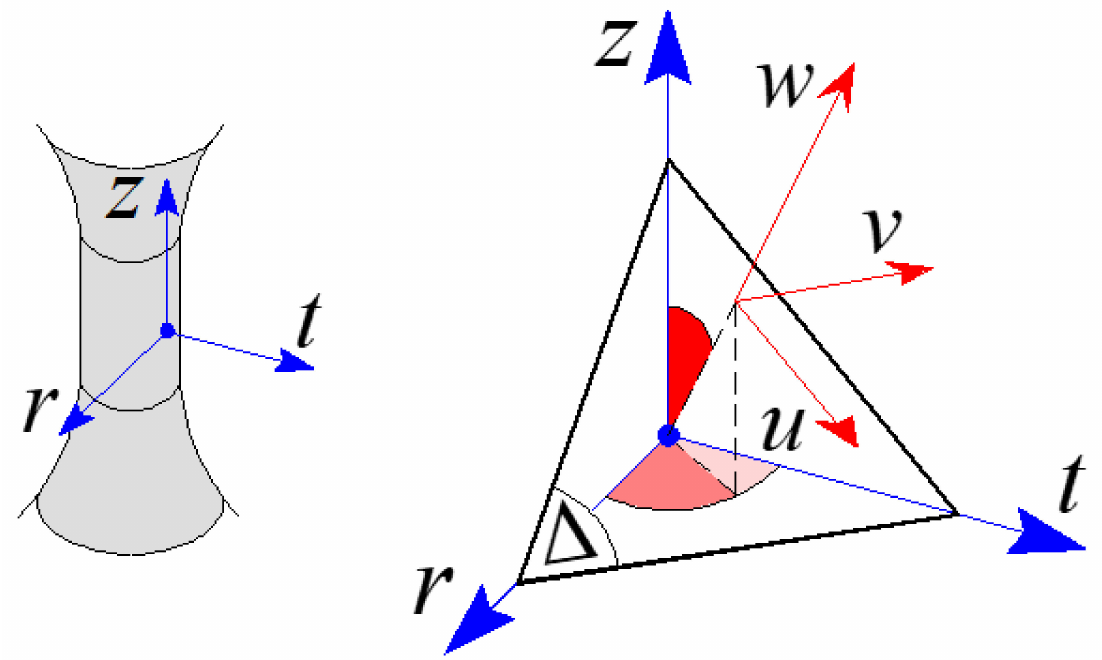
Figure 8. Global, rtz , and local, uvw